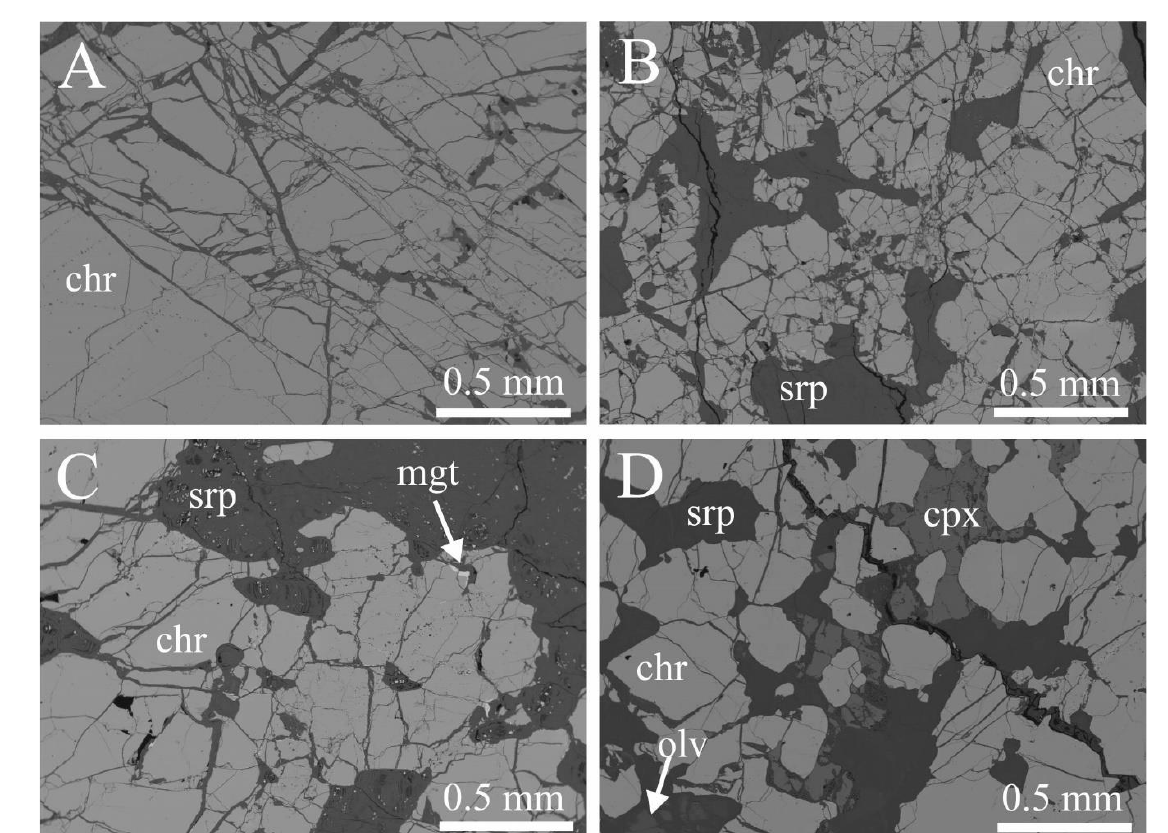
Figure 5. Back-scattered electron (BSE) images of the chromite texture. Massive chromitite composed of closely interlocked chromite crystals cut by cracks and fissures filled with serpentine (black) ( A ), fractured chromitite containing up to 30% interstitial silicate ( B ), lobate chromitite showing small spots of magnetite alterations ( C ), and preserved clinopyroxene and olivine occurring in the chromitite matrix ( D ). Abbreviations: chr = chromite, srp = serpentine, mgt = magnetite, cpx = clinopyroxene, and olv = olivine.